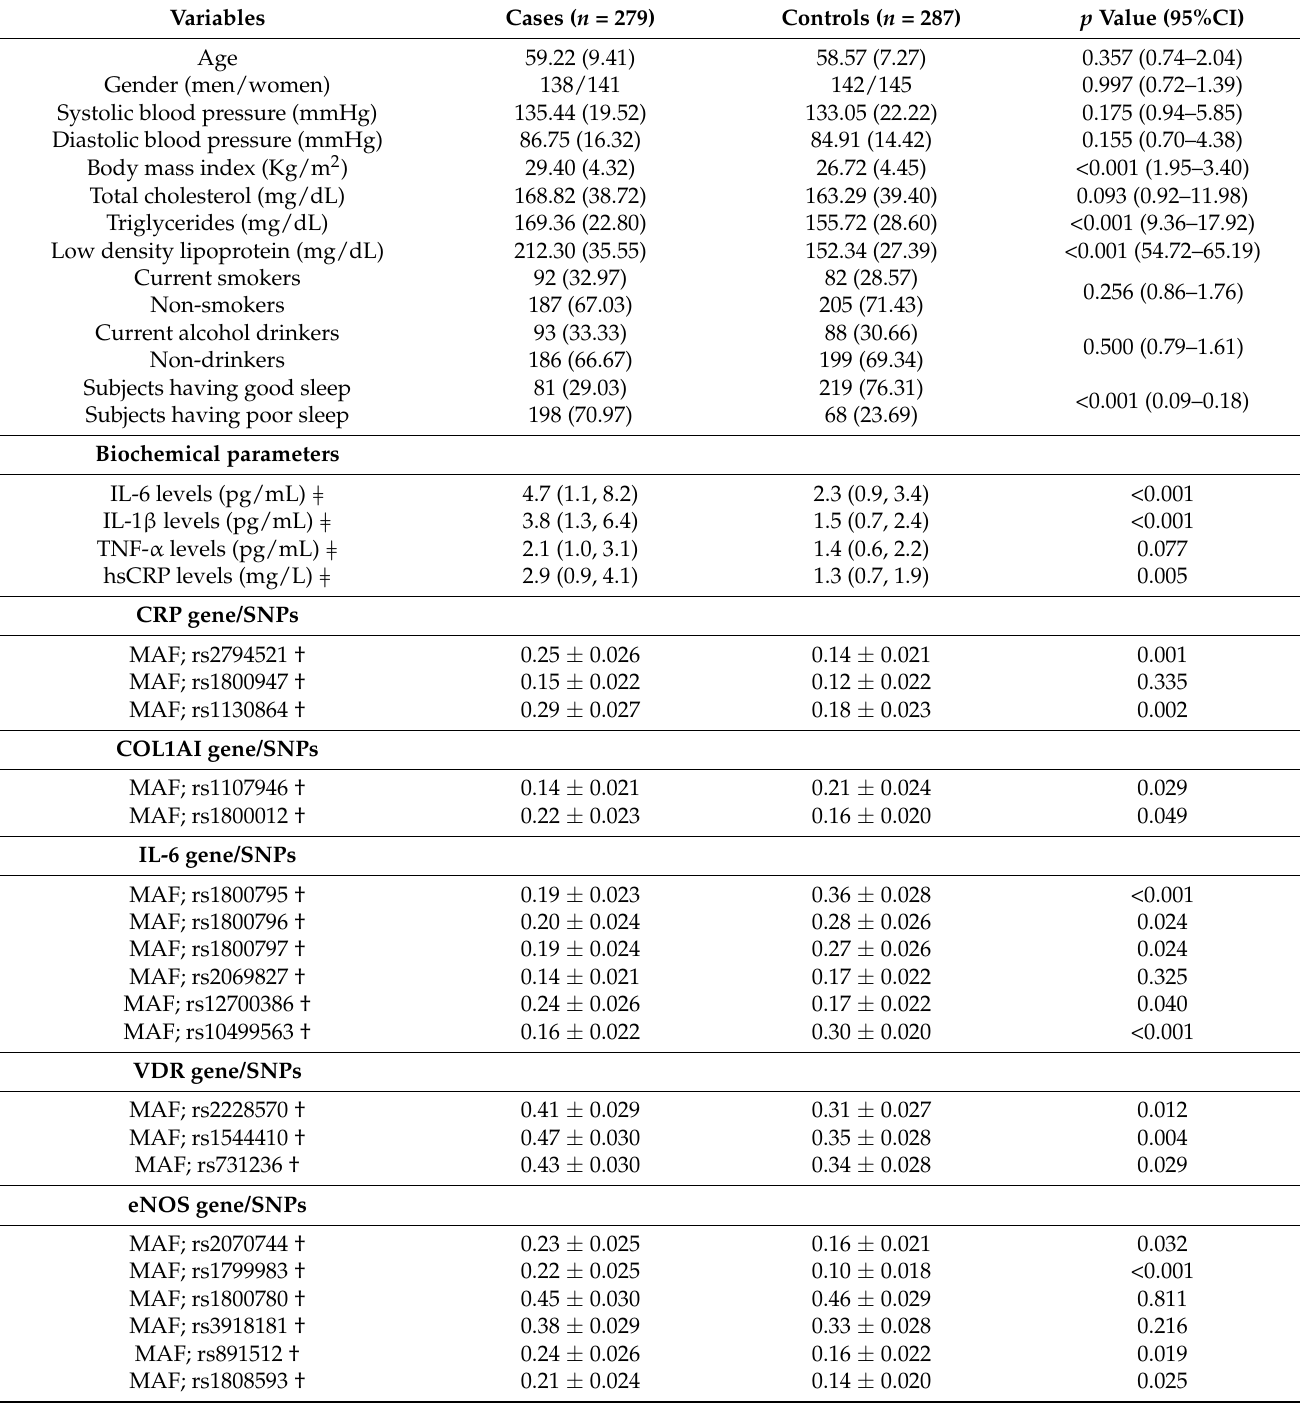
Table 1. Baseline variables of the study